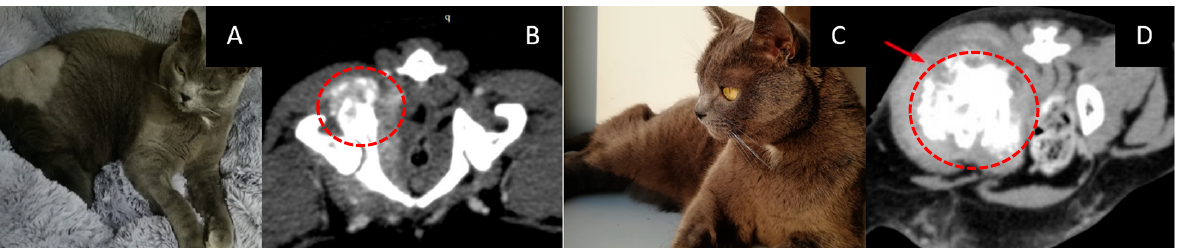
Figure 7. Male cat “Semyon” (6 years old) with osteogenic sarcoma of the right femur and iliac bone. Animal appearance before irradiation ( A ). CT scan before irradiation ( B ) showed a tumor 34 × 32 × 37 mm in size (dashed circle). Animal appearance after irradiation ( C ). CT scan three months after irradiation ( D ) revealed that the tumor had increased in size to 58 × 38 × 46 mm (arrow, dashed circle).